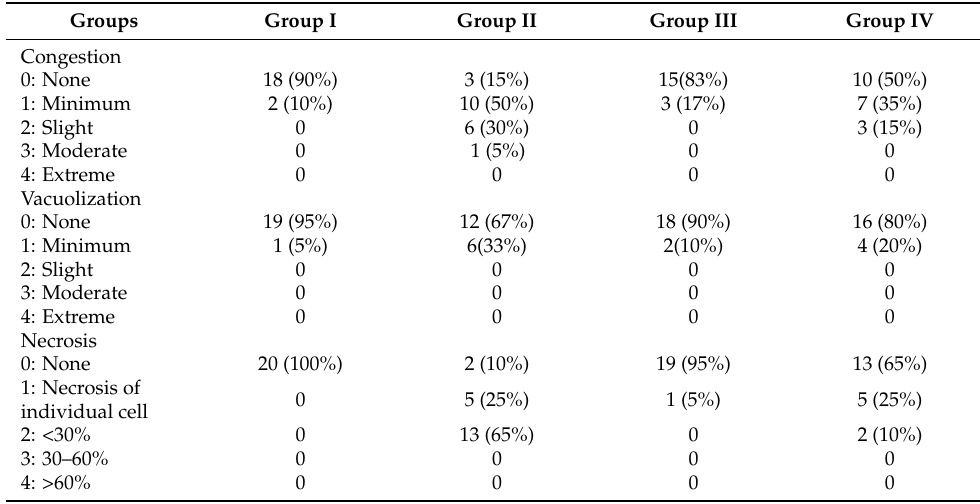
Table 2. Effect of carvedilol on number and frequency distribution (%) of each component examined in hepatic ischemia associated with isoprenaline-induced